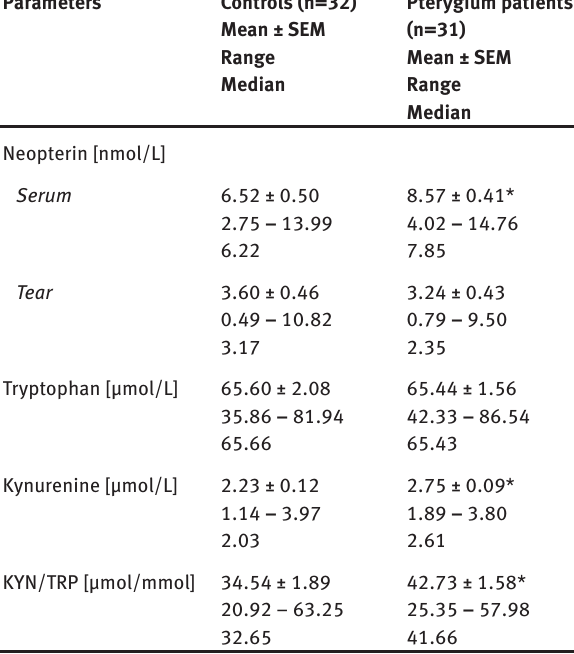
Table 1: Neopterin, tryptophan and kynurenine levels and KYN/TRP ratios from control and pterygium patient groups.